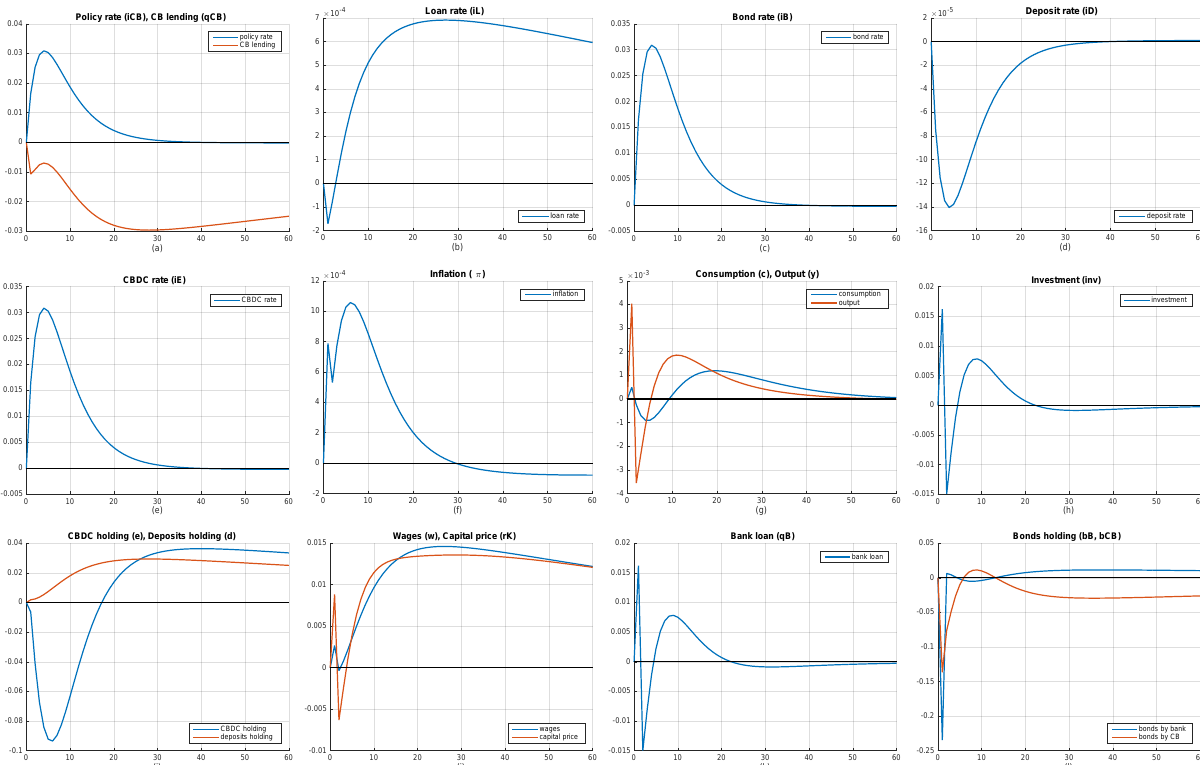
Figure 4. The effect of monetary policy shock on: ( a ) Policy rate i CB ( b ) loan rate i L , ( c ) bond rate i B , ( d ) deposit rate i D t t c t and output y t , ( h ) investment inv t , ( i ) CBDC holding e t and deposits d t , ( j ) wages w t and price of capital r K , ( k ) bank’s loan q B , and ( l ) bonds holding b B t t